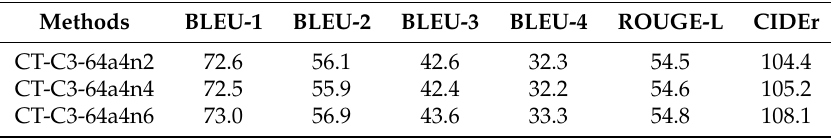
Table 3. The results of the CT model with the different decoder layers.